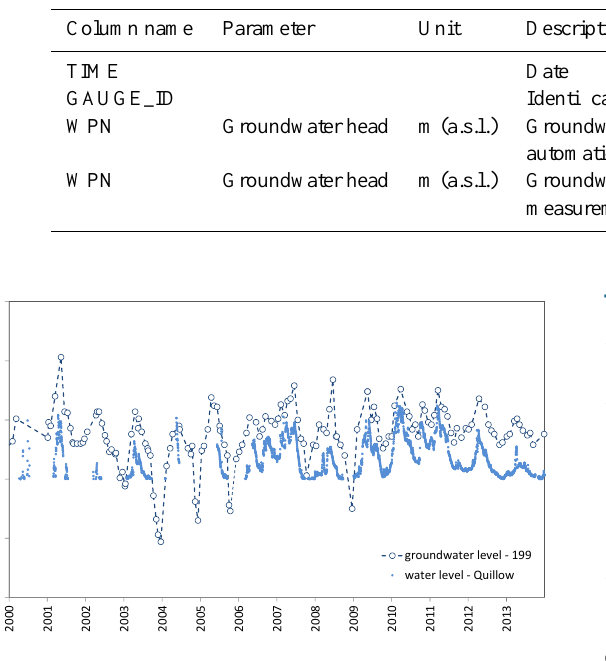
Figure 5. Comparison of surface water levels of the Quillow and groundwater heads of the unconfined upper aquifer at gauge posi- tion 199.